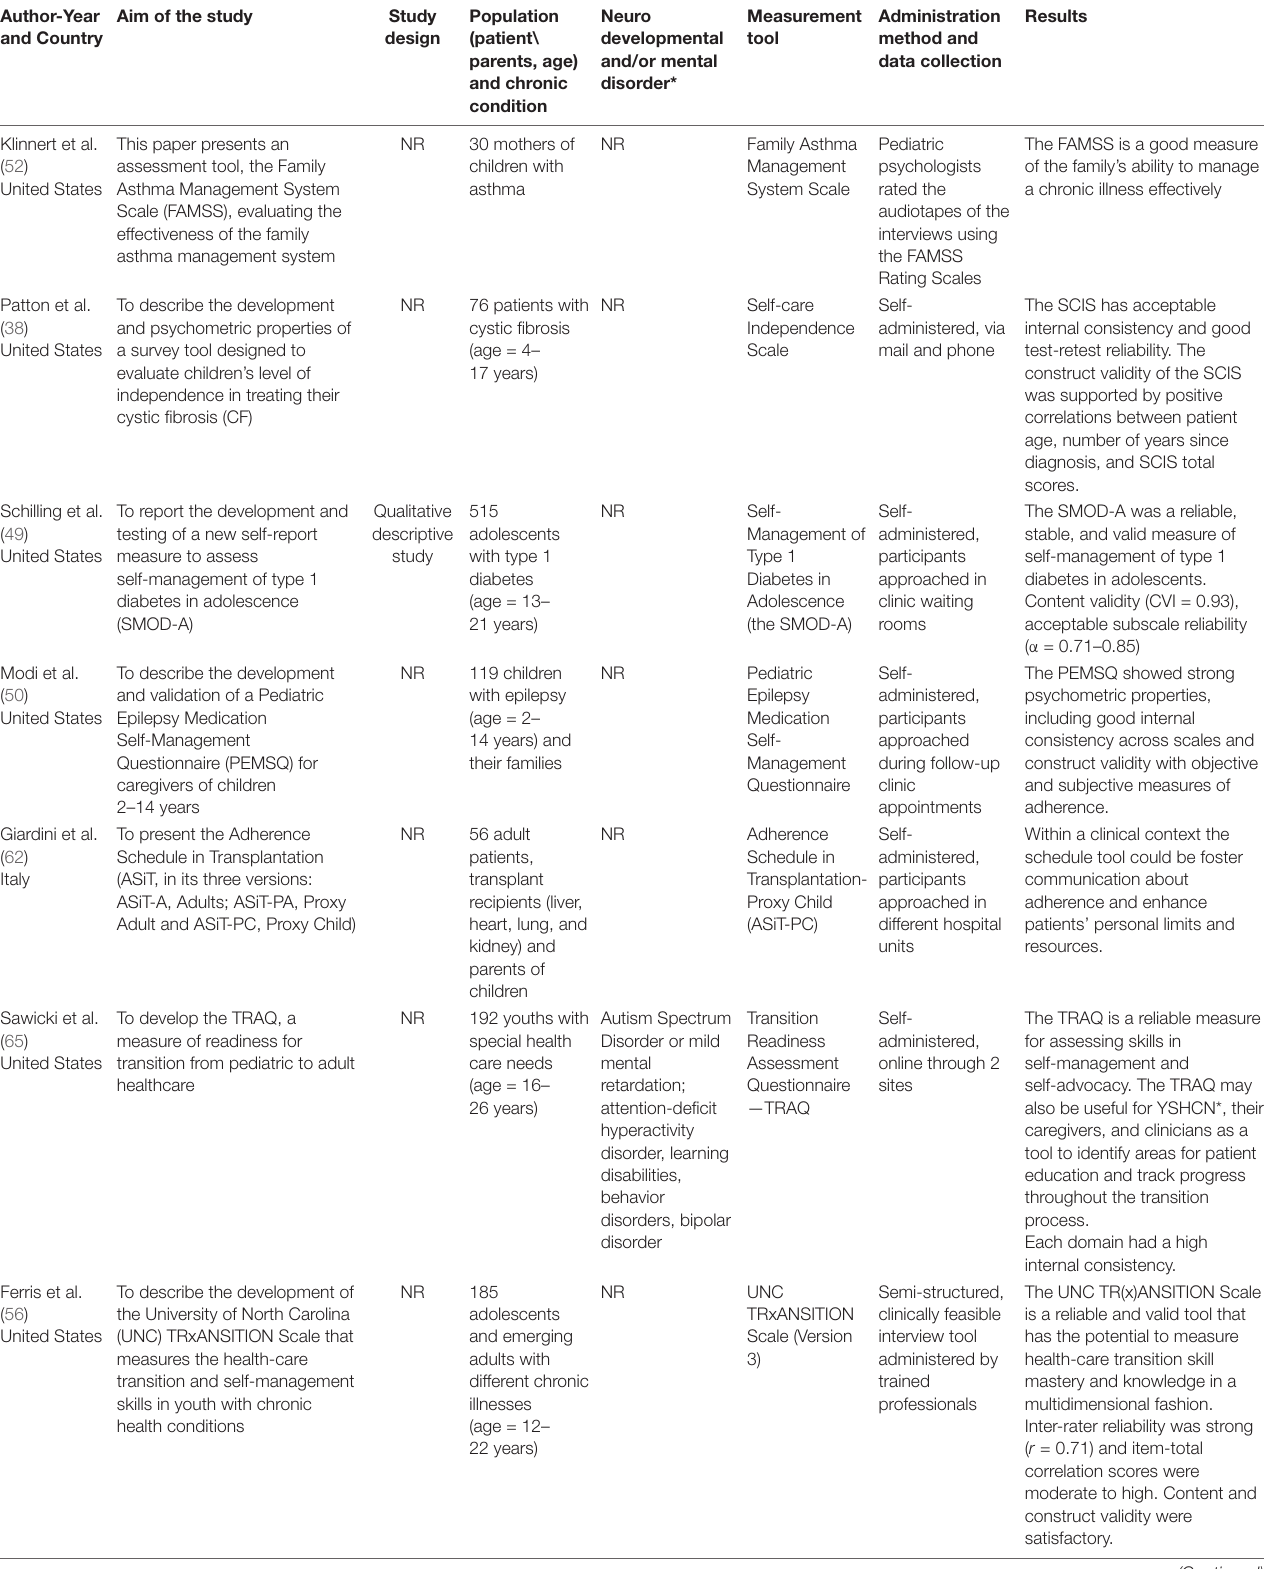
TABLE 1 | Characteristics of the articles included in the